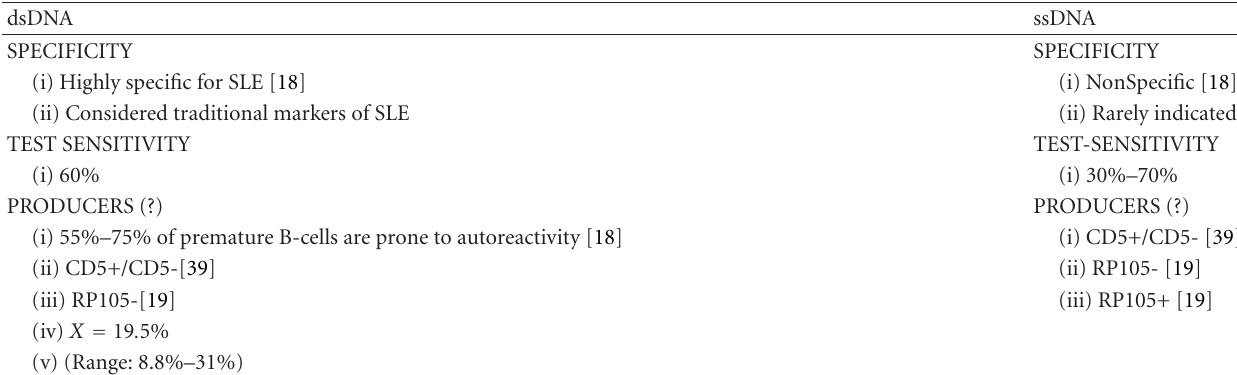
Table 1: Anti-DNA autoantibodies in SLE both belong to category of ANA 95%–98% Titer: 1:80 or lower is considered